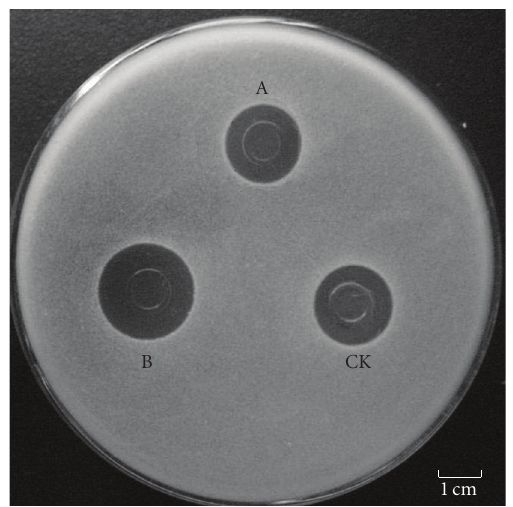
Figure 2: The antimicrobial activity in fermentation supernatants of strain Hhs.015 T to Candida vulgaris on PDA medium in 9- cm-diameter Petri dish. The antimicrobial activity was determined by measuring the translucent inhibition zones after incubating the dish 24 hours at 30 ◦ C. A: alternative culture medium at basal fermentation condition; B: alternative culture medium at the optimal fermentation condition; CK: SSY medium at the basal fermentation